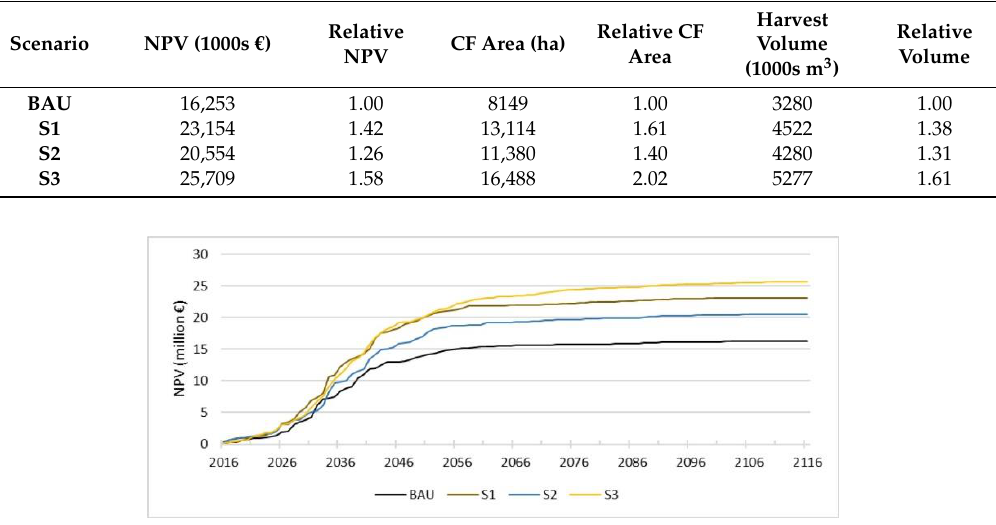
Figure 5. NPV development over time in the 100-year planning horizon for the BAU and three global scenarios.